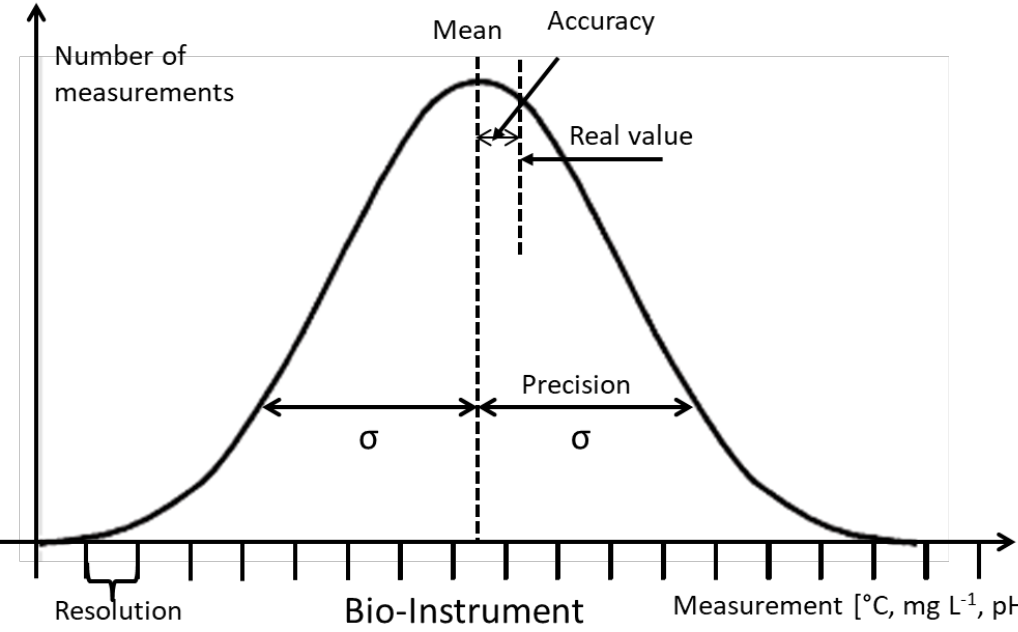
Figure 5. Normal distribution of instrument characteristics.